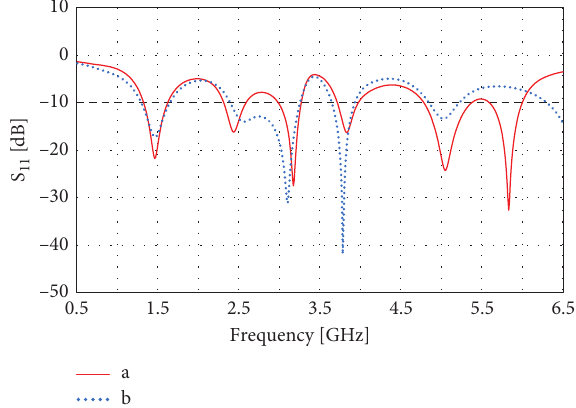
Figure 8: Comparison of antenna return loss between double-dent structure and trident